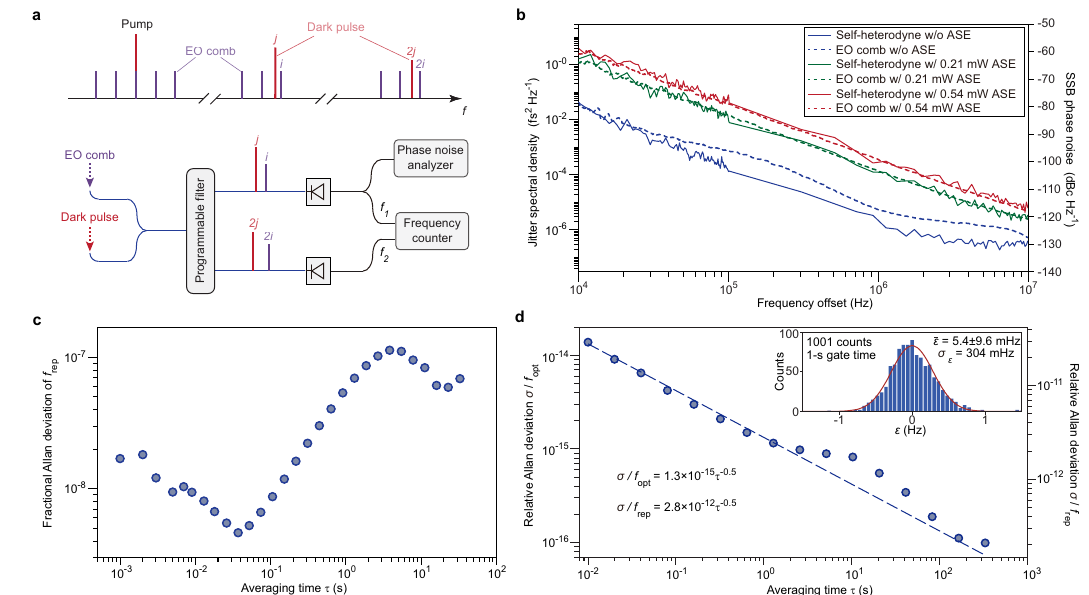
c Fractional Allan deviation of the repetition frequency of the free-running dark pulse. The gate time is set to 1ms. d Allan deviation of the deviation from equidi- stantmodespacing( ϵ )normalizedtoopticalcarrierfrequency( f opt )andrepetition frequency( f rep ).Thegatetimeissetto10ms.Thedashedlineis fi ttedbythesquare rootfunctiongiveninthe fi gure.Inset:distributionof1001pointsof ϵ measuredat 1-s gate time. The red line is a Gaussian fi t to the